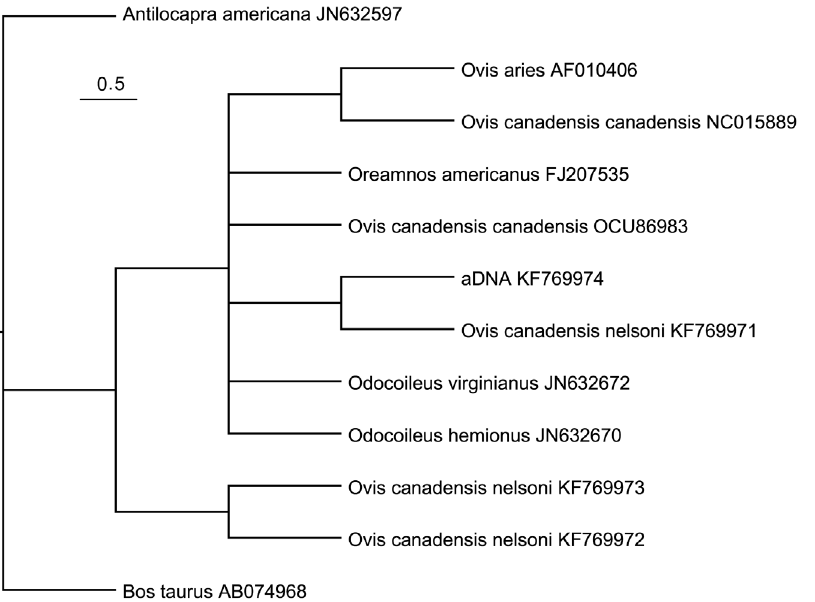
Figure 4. Phylogenetic tree for Isla Tiburo´n a DNA and ungulate sequences. Majority rule consensus tree from phylogenetic analysis of a 46 bp region of the 12S ribosomal RNA subunit of the mitochondrial genome, including the Isla Tiburo´n a DNA sample and published sequences from all ungulate species thought to have existed in the area since the start of the Holocene, with GenBank accession numbers. The phylogeny was inferred using parsimony and treating indels as a 5 th character state.